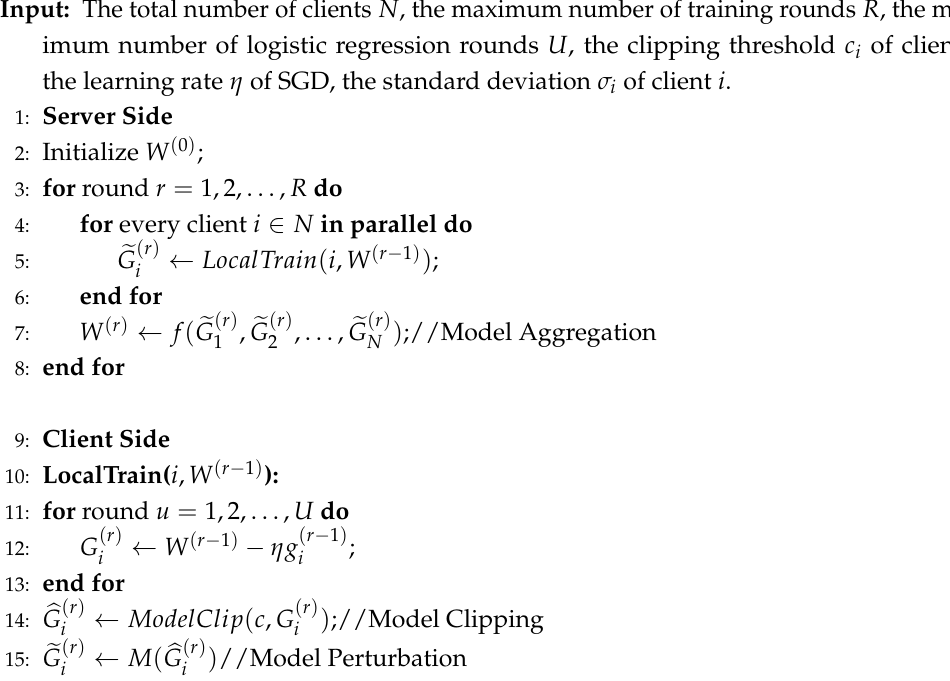
Algorithm 1 Federated learning with personalized local differential privacy on independent identically distributed